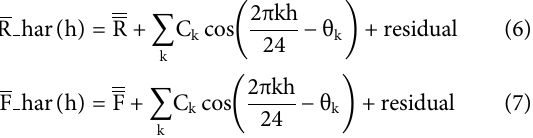
Frontiers in Earth Science |